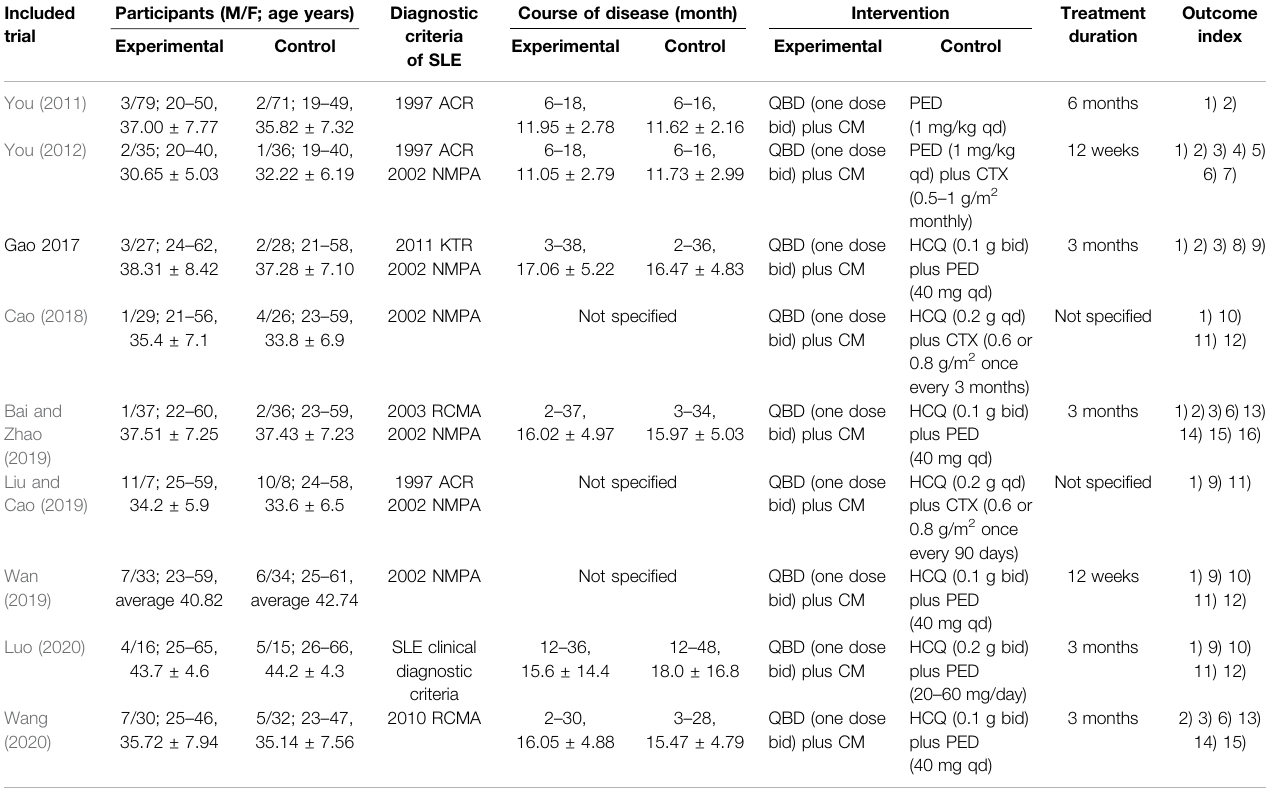
TABLE 1 | Basic characteristics of the included studies. Included